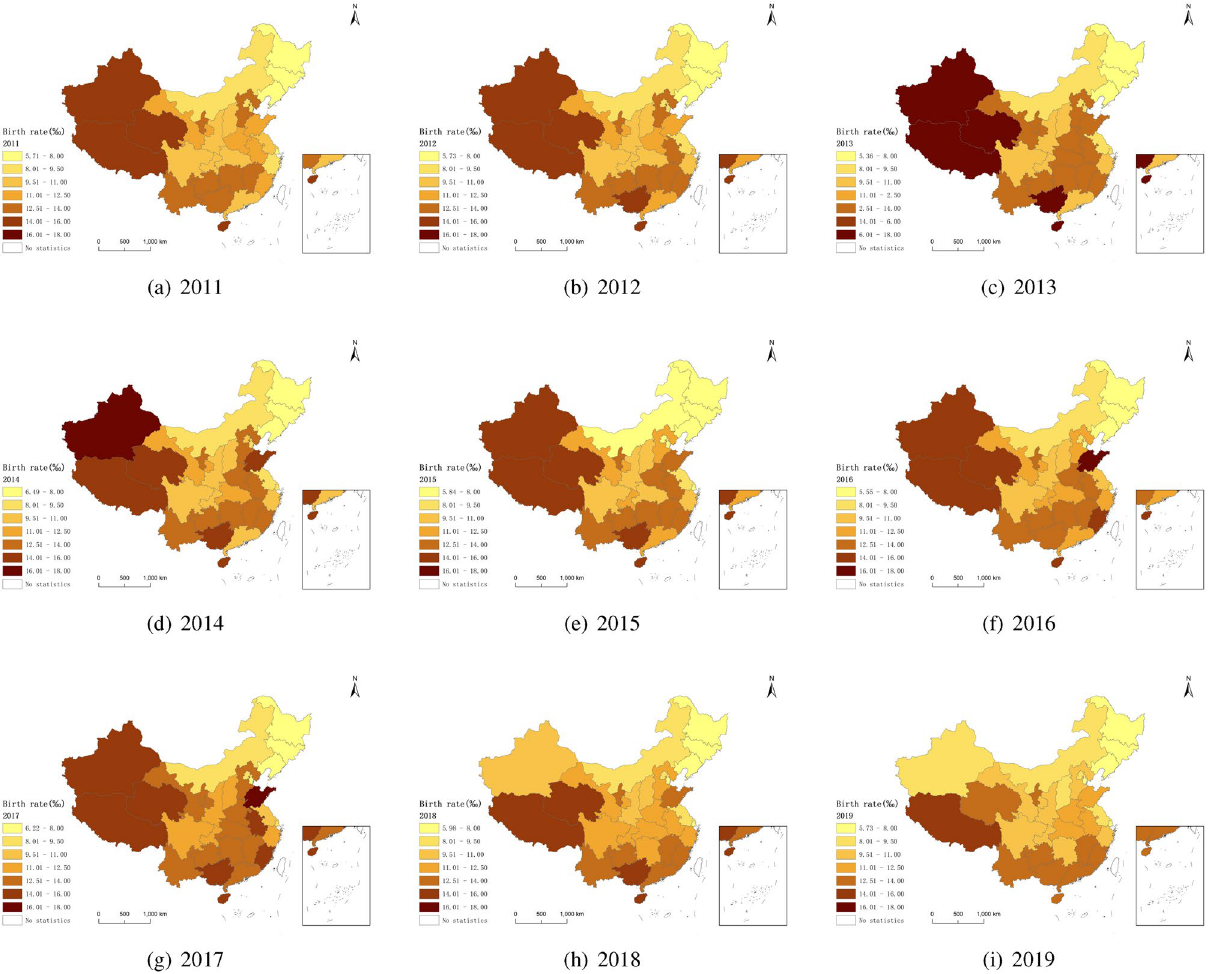
Figure 1. The trend of birth rate changes in 31 provinces in mainland China from 2011 to